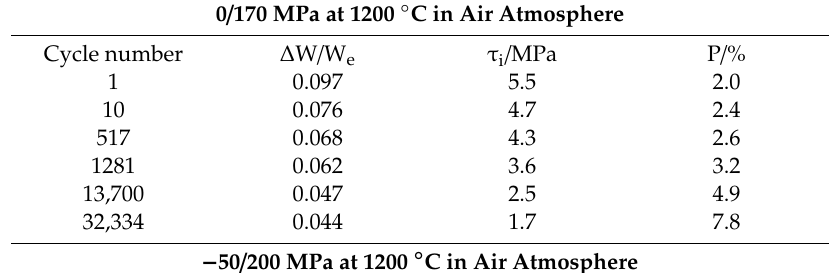
Figure 7. ( a ) Experimental and predicted internal friction parameter ( ∆ W / W e ) versus the interface shear stress curves: ( b ) the broken fiber fraction (P) versus the interface shear stress curves; ( c ) the experimental and predicted Kachanov’s damage parameter (D) versus cycle number curves; and ( d ) the interface shear stress versus cycle number curves of 2.5D woven self-healing Hi-Nicalon TM SiC / [Si-B-C] composite at 1200 ◦ C in an air atmosphere. Table 5. Cycle-dependent damage evolution of 2.5D woven self-healing Hi-Nicalon TM SiC / [Si-B-C] composite at 1200 ◦ C in an air